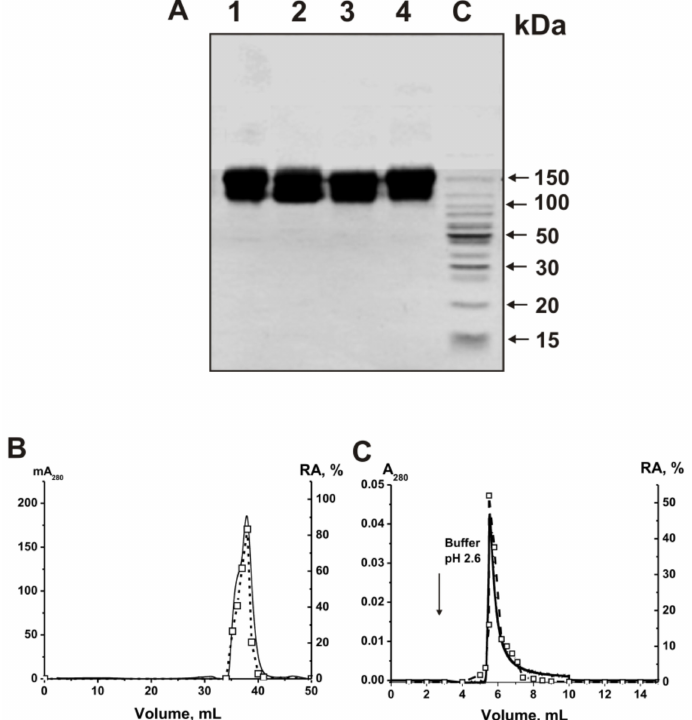
Figure 1. SDS-PAGE analysis of the electrophoretic homogeneity of ms-IgG1 (Lane 1), ms-IgG mix (multiple sclerosis (MS) patients; Lane 2), healthy-IgG1 (Lane 3), and healthy-IgG mix (healthy donors; Lane 4) in 4–18% gradient gel, followed by silver staining (15 µ g IgGs were used). ( A ) Ms-IgG1 and healthy-IgG1 correspond to individual antibodies. The arrows (Lane C) indicate the positions of protein molecular mass markers. Ms-IgG mix FPLC gel filtration on a Superdex 200 column equilibrated with acidic buffer (pH 2.6) after Abs preincubation using this buffer ( B ), and affinity chromatography of the ms-IgG mix on anti-IgG-sepharose bearing mouse Abs against human IgGs ( C ). (—), absorbance at 280 nm (A 280 ); ( (cid:3) ), RAs (%) of ms-IgG mix in the hydrolysis of RNA ( B , C ). Complete hydrolysis of miR-326 for 7 h using 5 µ l of the eluate was taken for 100% ( B , C ). The error from two experiments in the initial rate determination in each case did not exceed